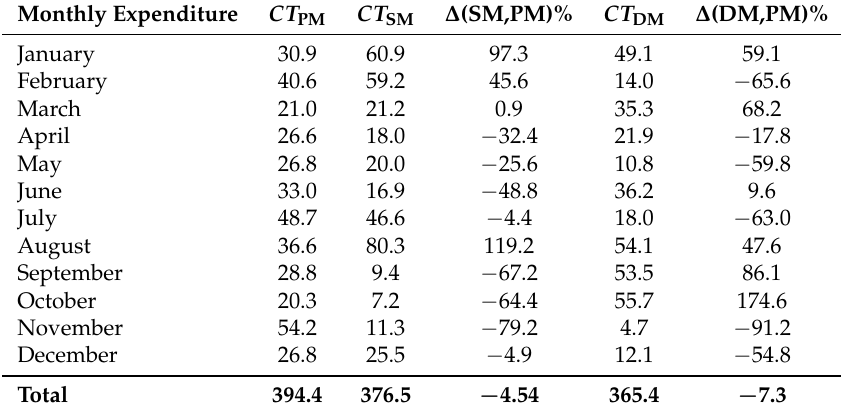
Table 3. Comparison of the monthly CT values (in millions of Chilean pesos) associated to the different methods for 2018. CT PM CT SM ∆ (SM,PM)% CT DM ∆